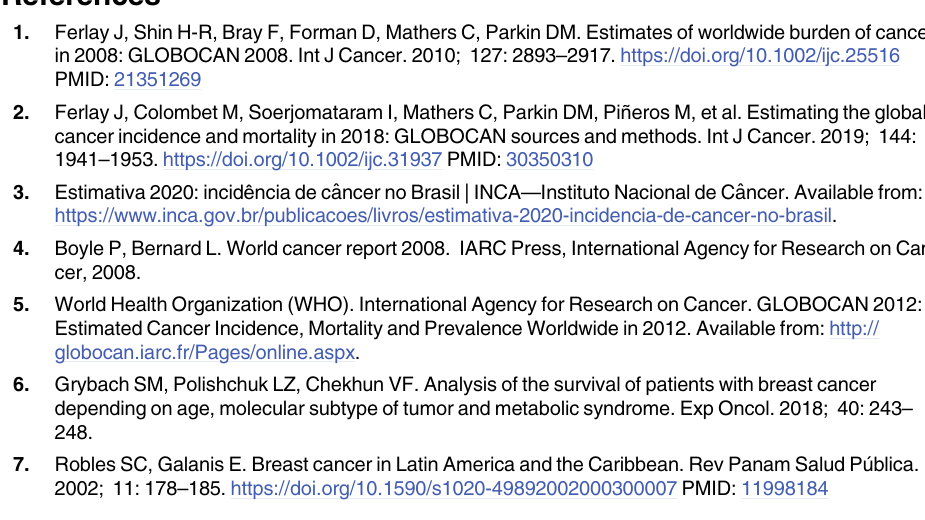
S2 Fig. The proportional hazards assumptions for the cox model, considering specific sur- vival